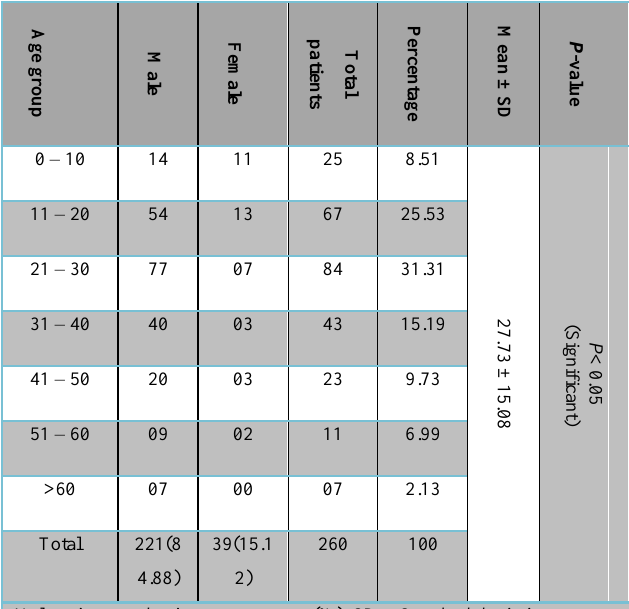
Table 1. Age &gender distribution among the study sample.